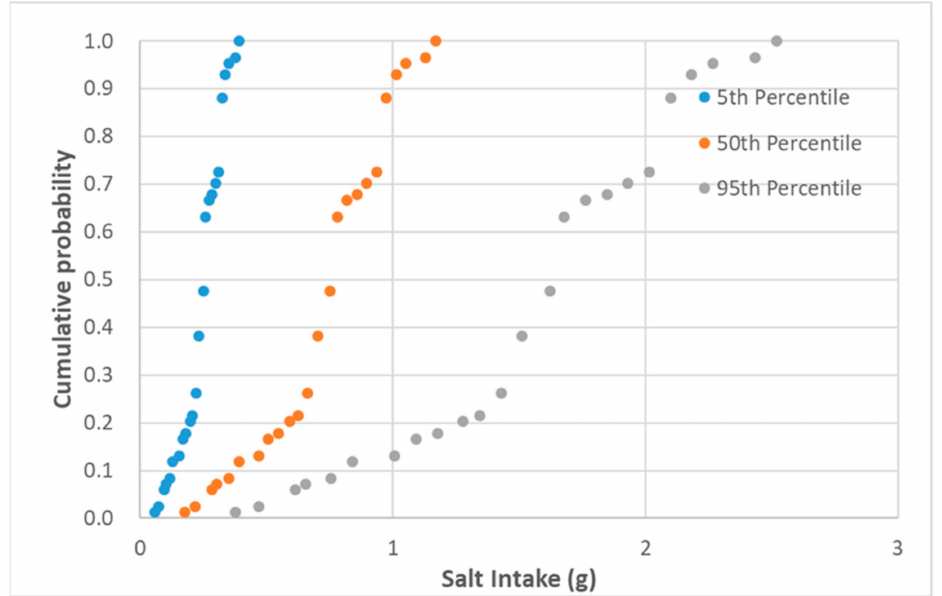
Figure 4. Cumulative probability of salt (g) intake per capita and per day of Greek adults consum- ing graviera cheese marketed in the Greek market for the 5th, 50th and 95th percentiles of daily